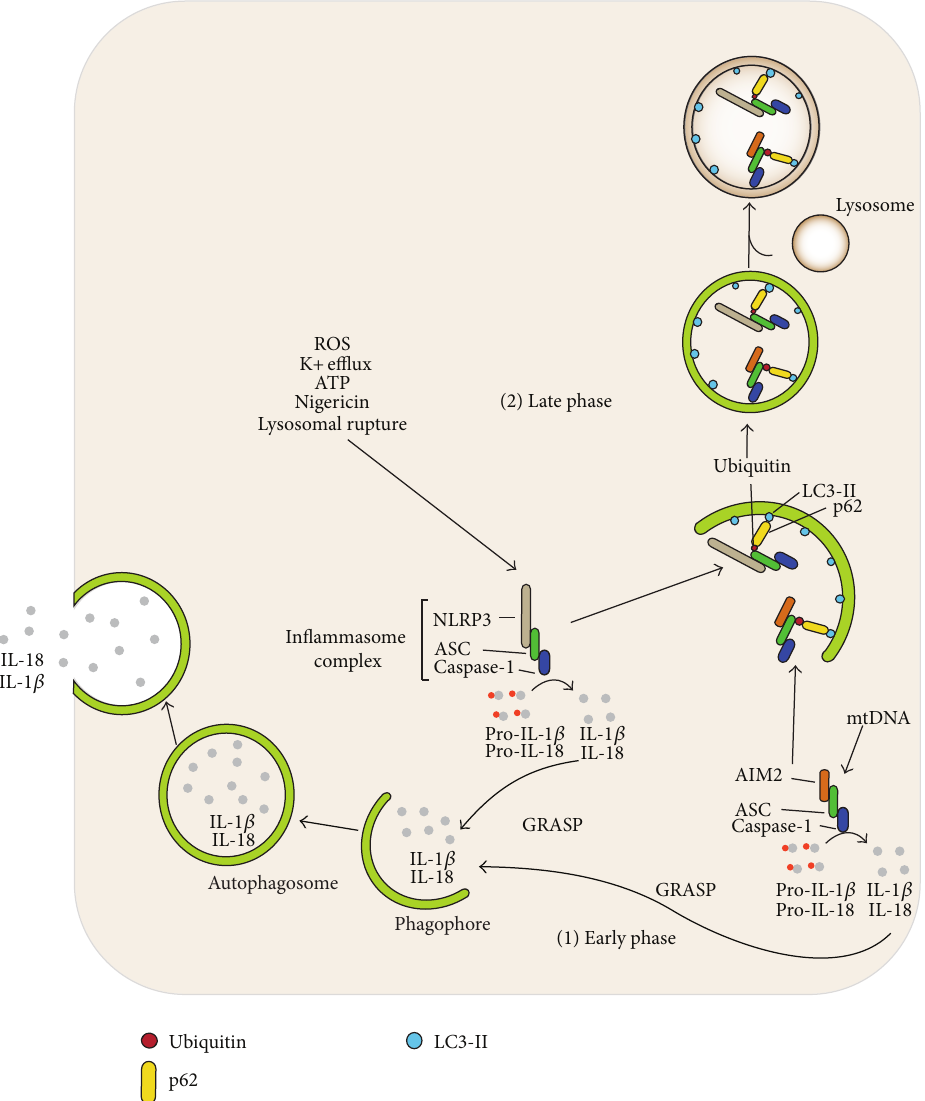
Figure 3: The regulation of early and late phases of inflammasome activity through the autophagic process is shown. Distinct inflammasome complexes are assembled by a variety of different stimuli. For example, reactive oxygen species (ROS), adenosine triphosphate (ATP), potassium efflux, nigericin, and lysosomal rupture trigger the activation of the sensor molecule NLRP3, whereas mitochondrial DNA (mtDNA)andpathogen-associatedDNAactivatethesensormoleculeAIM2.Theactivationofsensormoleculesleadstotheiroligomerization and further assembly of inflammasome complexes by recruiting adaptor protein ASC and procaspase-1 leading to the cleavage of the proform. Activatedcaspase-1thencleavestheproinflammatorycytokineprecursorsprointerleukin-1 𝛽 (pro-IL-1 𝛽 )andpro-IL-18intobiologicallyactive forms of IL-1 𝛽 and IL-18. (1) At the early phase of inflammasome activation, biologically active forms of IL-1 𝛽 and IL-18 are transported into autophagic vesicles via GRASP proteins and secreted outside of the cell through autophagic vesicles. Hence, autophagic pathway regulates inflammasome activity by contributing the secretion of IL-1 𝛽 and IL-18. (2) In the late phase, inflammasome complexes are selectively degraded by autophagic vesicles. The multimeric inflammasome structures are ubiquitinated; one target is the adaptor protein ASC. The autophagic adaptor protein p62 mediates the recruitment of ubiquitinated inflammasomes as autophagic cargo into autophagic vesicles. Inflammasome structures are later degraded by hydrolytic enzymes following lysosomal fusion. Hence, the autophagic pathway acts to limit inflammasome activity by engulfing and degrading